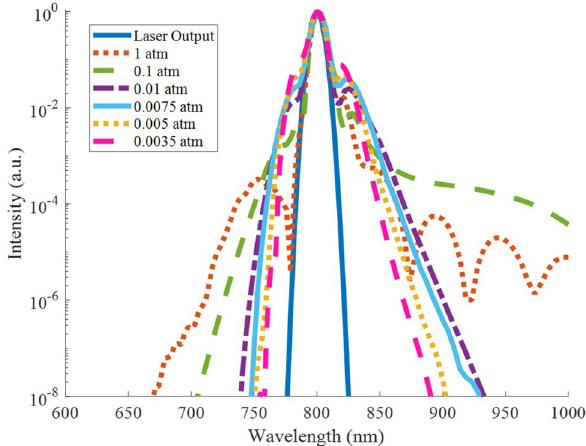
Figure 5. Simulated spectral broadening from 1 to 0.0035 atm compared to the laser